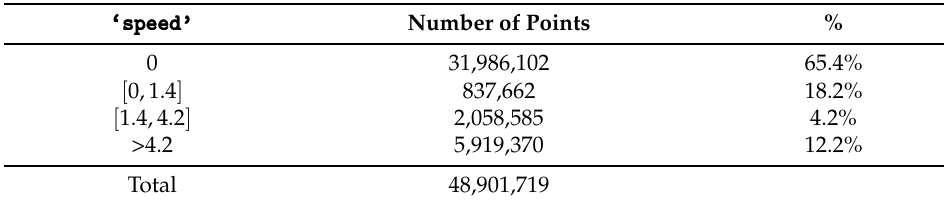
Table 12. Distribution of ‘speed’ for points with geolocalization.